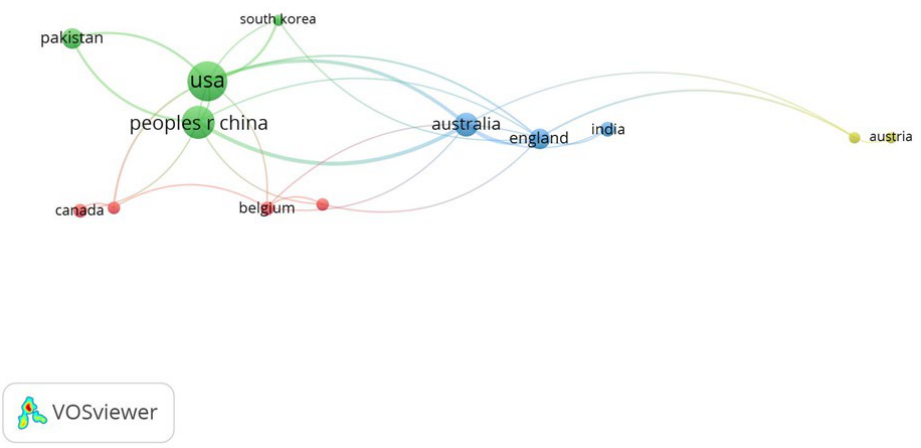
Figure 8. Co-authorship networks between countries with more contribution and cooperation between them.